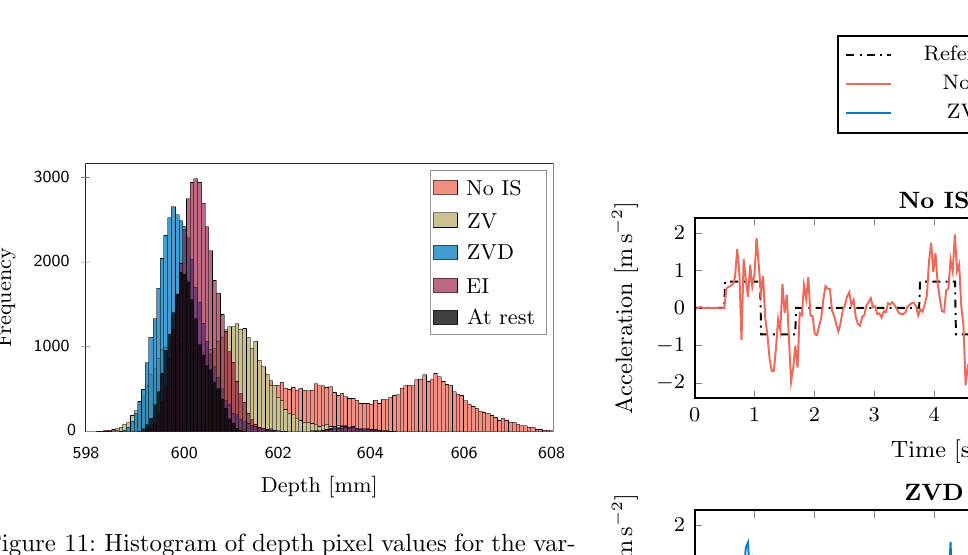
Figure 11: Histogram of depth pixel values for the var- ious shapers during 50 frames, acquiring a planar surface.